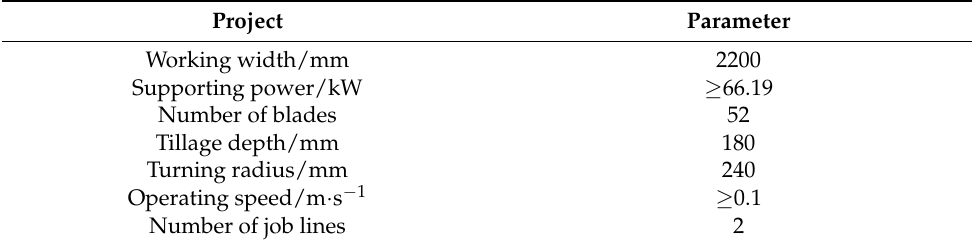
Table 1. Main technical parameters of